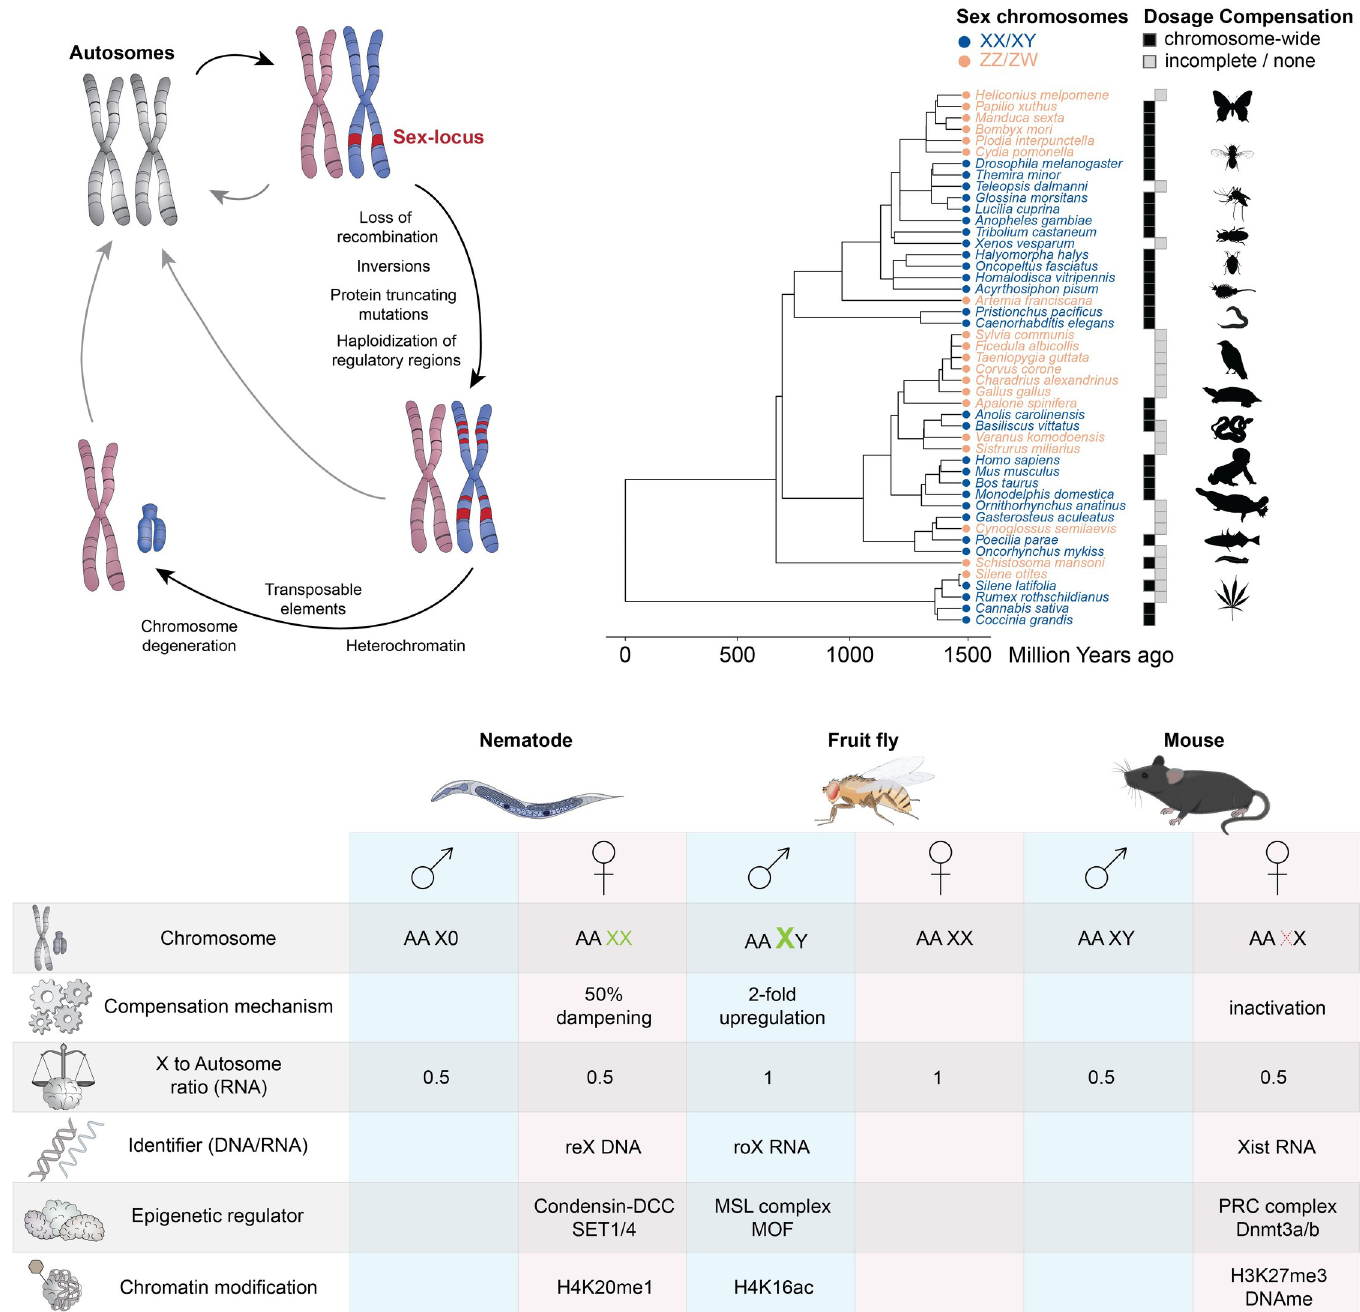
Fig 2. Sex chromosomes and DC. (Top left) Sex chromosomes are highly dynamic and show recurrent turnovers illustrated by gray arrows. They typically evolve from a pair of regular autosomes after acquisition of a sex-determining locus. Recombination starts to be repressed and the future Y (in the case of a male heterogametic species) or W (in the case of a female heterogametic species) acquire more and more protein truncating mutations. This process results in gradual functional heterozygosity of the X or Z chromosome (pink). In some organisms, the sex chromosomes then become fully degenerated and are sometimes even entirely lost, but there are also many species, where sex chromosomes do not decay [37]. Despite degeneration, some genes can be retained [41] or even become expanded on the degenerating Y/W [108]. (Top right) Evolutionary tree showing multiple species across the animal and plant kingdom, where DC has been studied. XY and ZW sex chromosome systems are colored in blue and orange, respectively, and the presence of chromosome-wide versus gene by gene/absence of DC are illustrated with black and gray boxes. Pictograms (images: phylopic.org) are only shown for illustrative purposes and do not depict the actual species in the tree; also see references and comments in S1 File. (Bottom) Comparison of the 3 known molecular mechanisms achieving DC by up-regulation of the X in males ( Drosophila ), inactivation of the X in females (mammals) or dampening of the 2 X by half in hermaphrodites (nematodes) are compared in the table. In Drosophila , both X-to-autosome as well as male-to-female DC is reached. Mammalian females